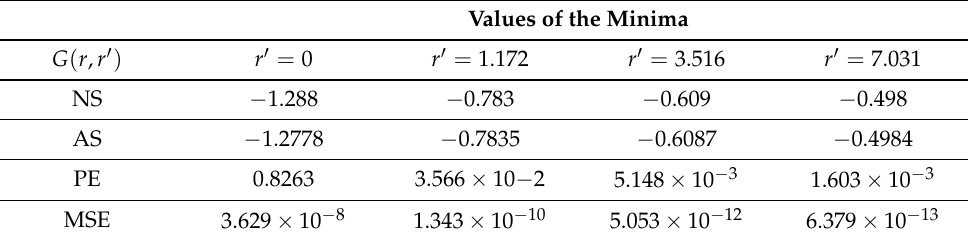
Table 7. Values of the minima shown in Figure 3 for the numerical solution (NS) and analytical solution (AS). PE means percentage error (from 0 to 100%) and MSE is the mean square error. Values of the